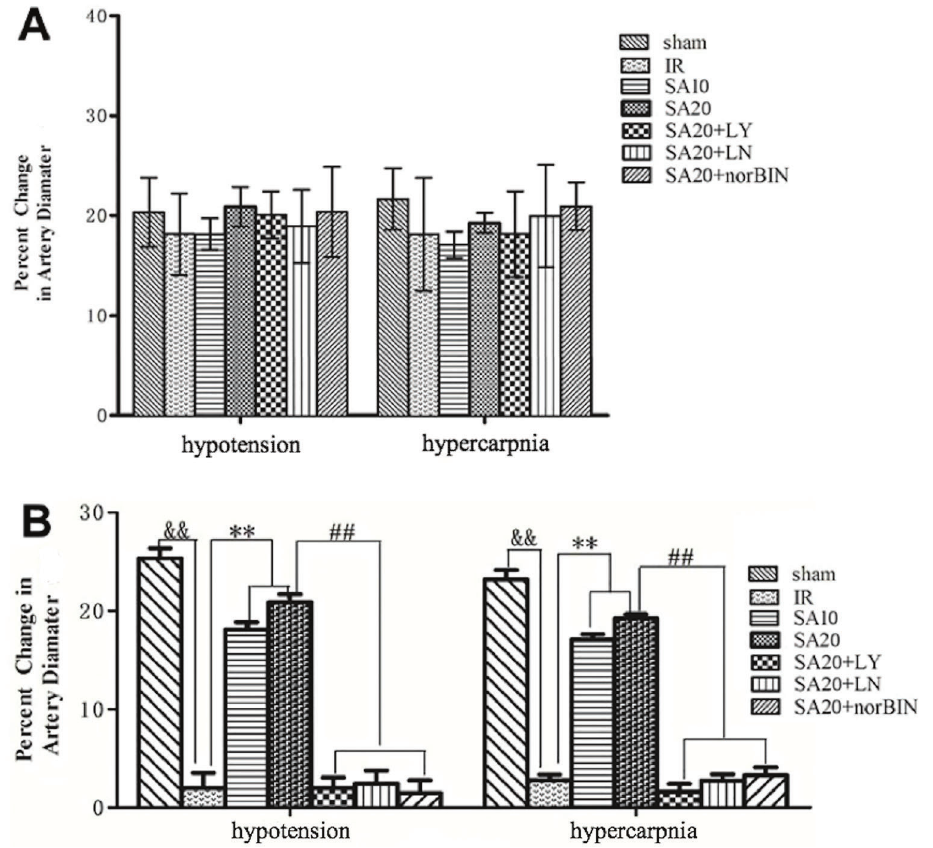
Figure 3. Salvinorin A (SA) preserved cerebral pial artery autoregulation after cerebral cortex ischemia. SA10, SA20, SA20 + LY294002, SA20 + L-NAME, SA20 + norBIN were administered, and the cerebral pial artery autoregulation was evaluated. A , No signi fi cant differences were found in the pial artery autoregulation among different groups before ischemia. B , Pial artery autoregulation among different groups after ischemia. Data are reported as means ± SD for n=6. && P o 0.01 compared to the sham control group, **P o 0.01 compared to the IR (DMSO) group, ## P o 0.01 compared to the SA2 treatment group. The pial artery autoregulation was analyzed by one-way ANOVA followed by Tukey ’ s test. LY: LY294002 (10 m M, injected topically); LN: L-NAME (10 m M, injected topically); IR (ischemia reperfusion control, DMSO): 1 m L/kg ( iv ); SA10: salvinorin A (10 m g/kg, iv ); SA20: salvinorin A (20 m g/kg, iv ); norBIN: norbinaltorphimine 1 m M (injected